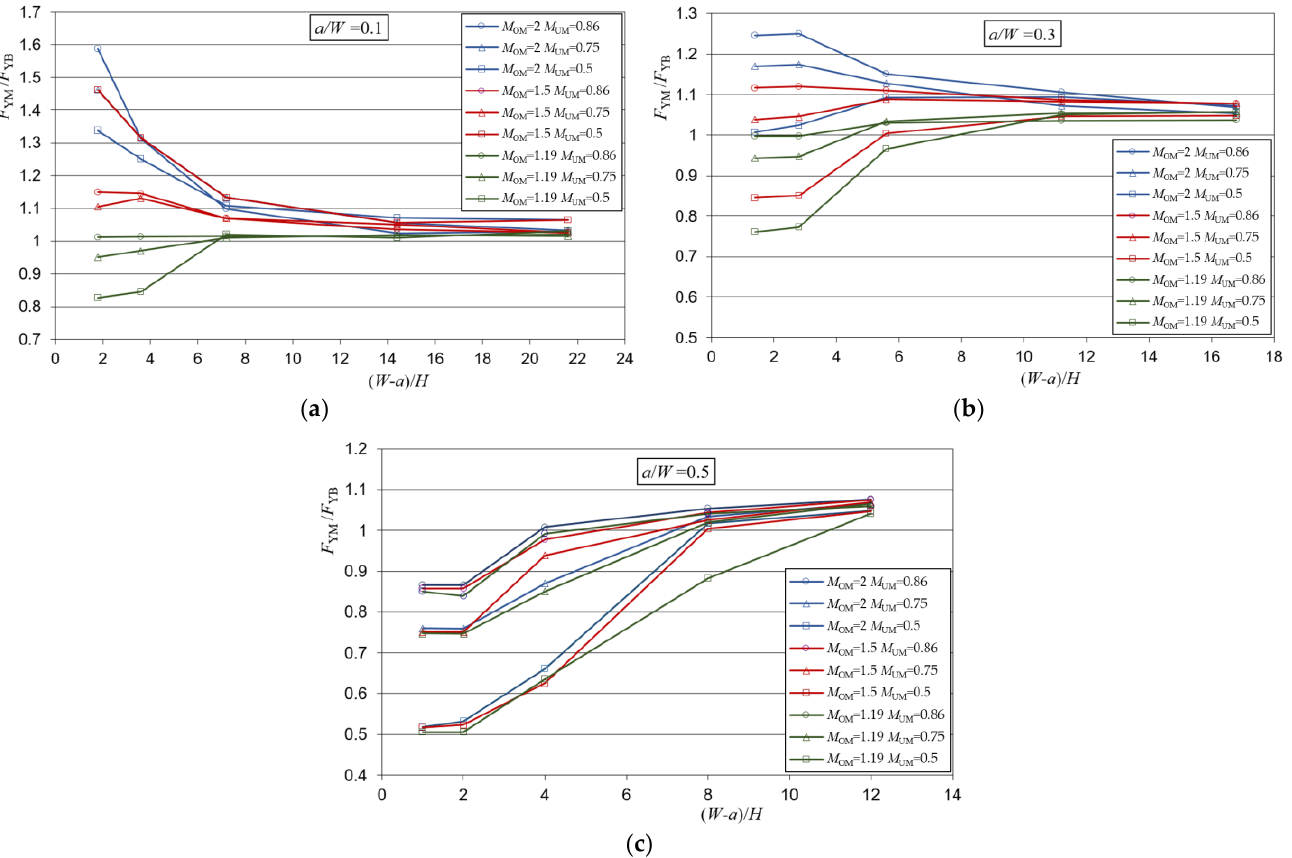
Figure 4. Mismatch yield loads for the heterogeneous weld and for a crack in the over-matched part of the weld: ( a ) shallow crack — a / W = 0.1; ( b ) medium length crack — a / W = 0.3; ( c ) deep crack — a / W =